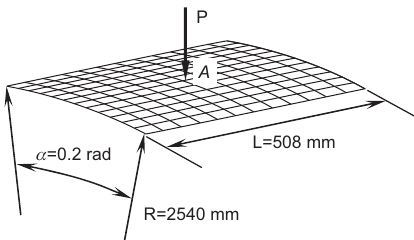
Figure 17 Geometry of cylindrical hinged shell.